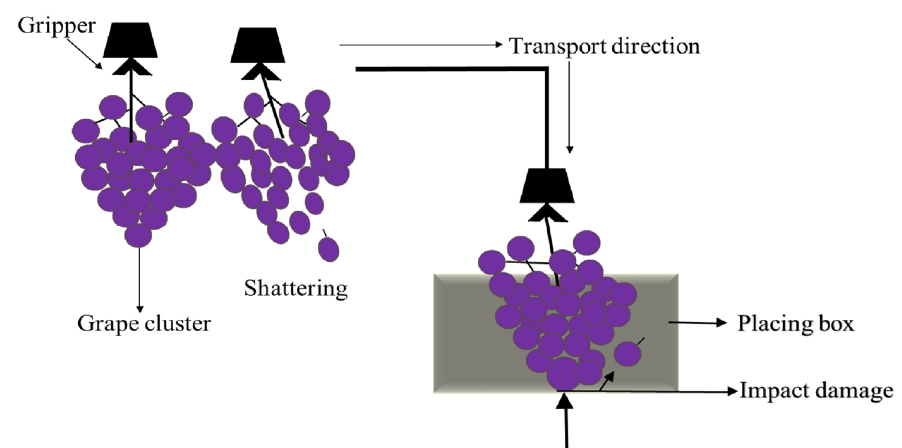
Figure 2. Different excitation transmissions and damage of grape cluster fruit during robotic trans- portation and placing cycles.